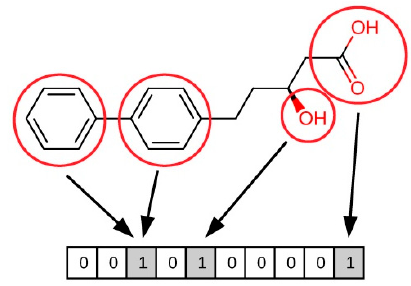
Figure 2. Illustration of how fingerprint bits are derived from the structure of a molecule.